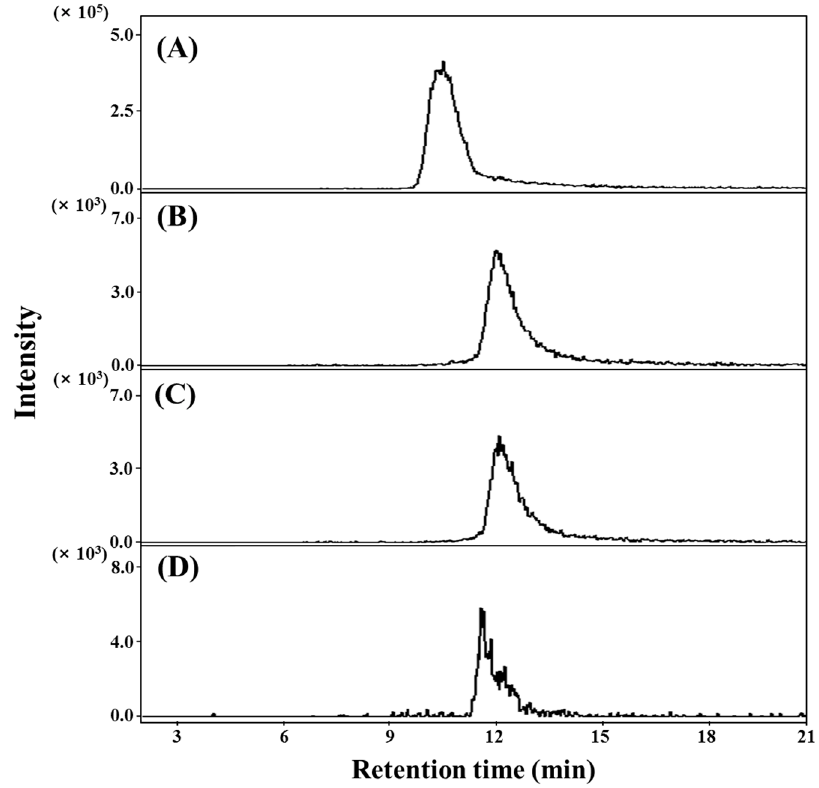
Figure 2. MRM chromatogram for: 3 ( A ); 4 ( B ); 5 ( C ); and 6 ( D ) in Salicornia herbacea . Dicaffeoylquinic acid derivatives were analyzed by LC-ESI-MS/MS. Compounds were detected by MRM: m/z 517.0 [M − H] – → 355.2 for 3 ; m/z 531.0 [M − H] – → 161.0 for 4 , m/z 531.0 [M − H] – → 161.0 for 5 , and m/z 533.0 [M − H] – → 184.2 for 6 . Detailed procedures for LC-ESI-MS/MS analysis have been described in Materials and Methods.